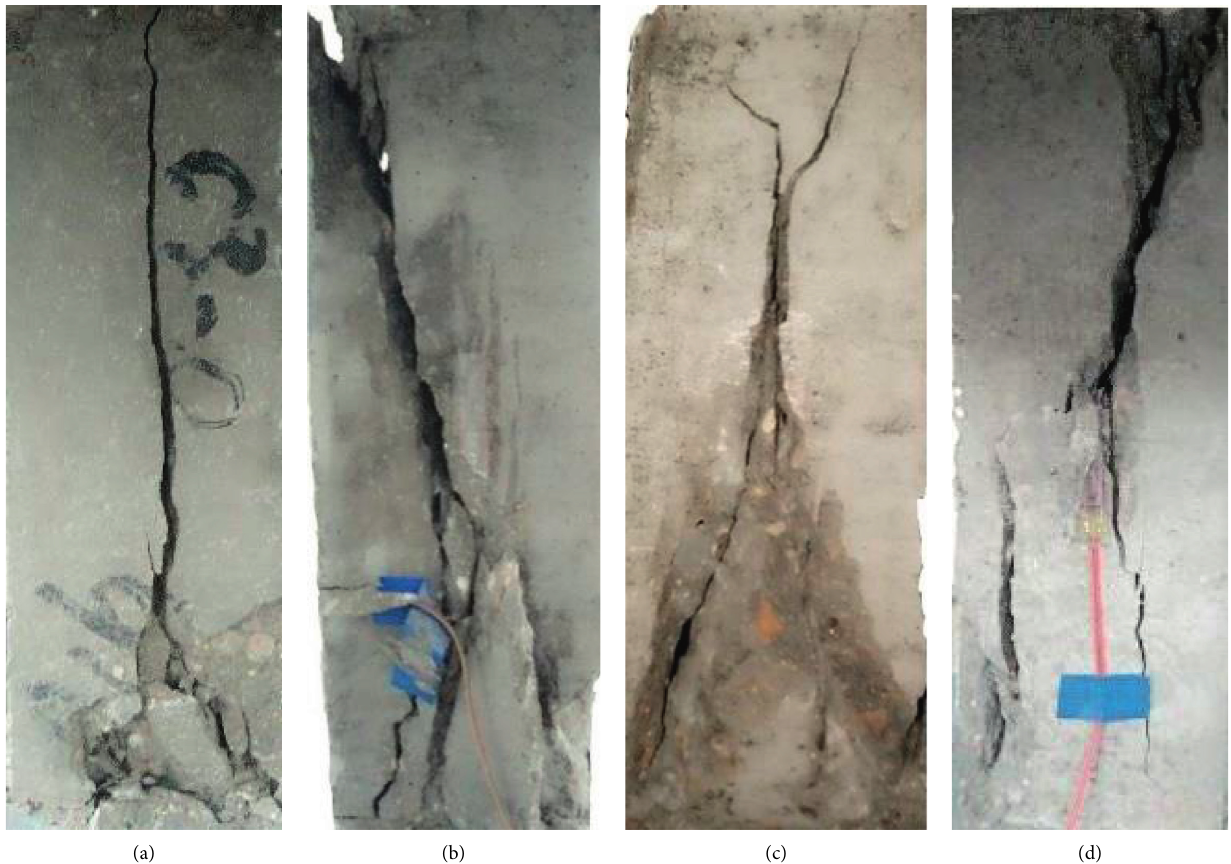
Figure 11: Failure modes of concrete with fly ash replacement ratios of (a) 0, (b) 20, (c) 35, and (d) 50 wt% under creep uniaxial compression.